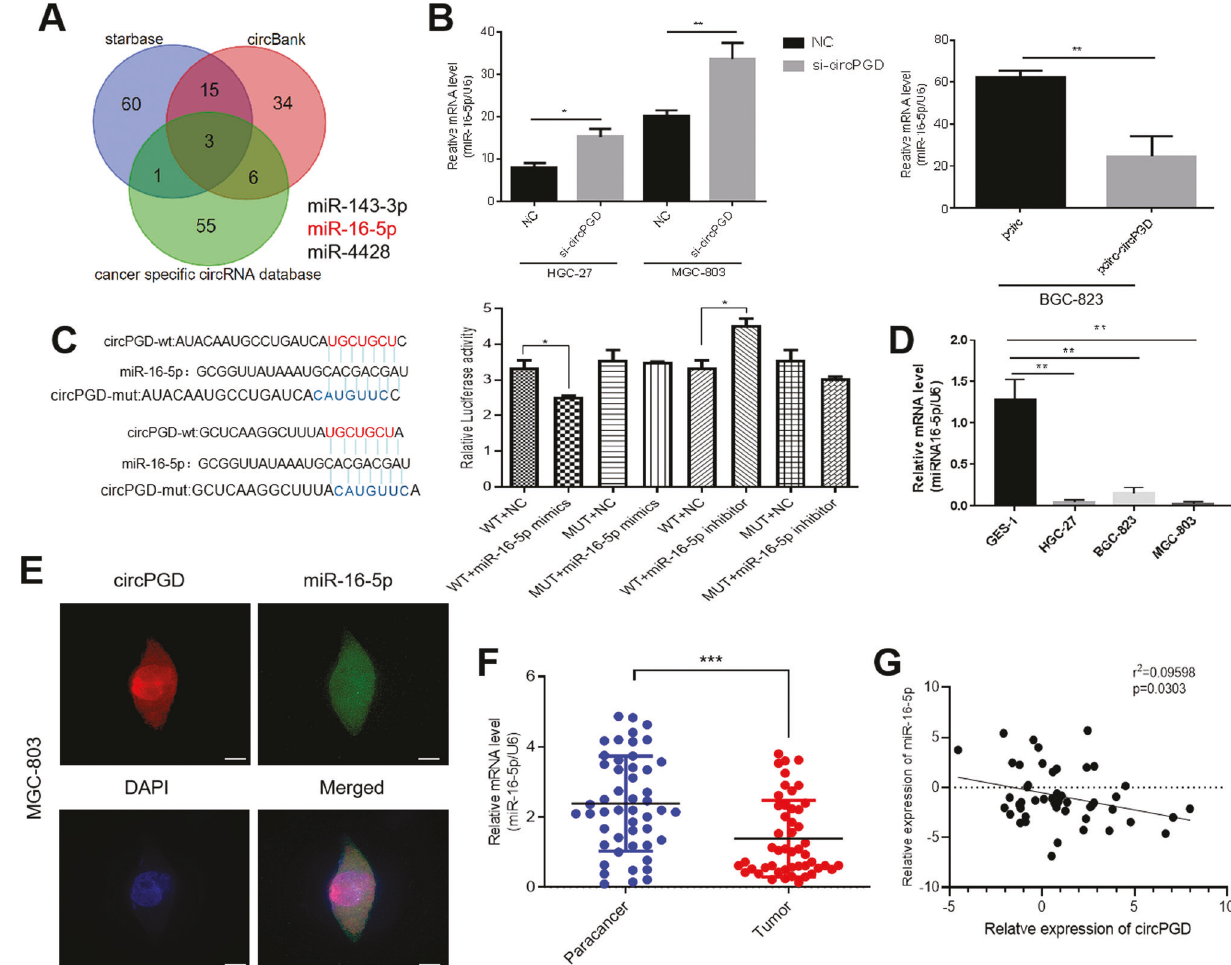
Fig. 3 CircPGD sponges miR-16-5p. A Three public databases estimated circPGD target miRNAs. B qRT-PCR monitored miR-16-5p level after abnormal circPGD level within GC cells. C The dual-luciferase reporter assay demonstrated the existence of binding sites in circPGD with miR- 16-5p. D qRT-PCR detected miR-16-5p level within GES-1 and GC cell lines. E Immuno fl uorescence detected circPGD together with miR-16-5p co-localization within MGC-803 cells, scale bars = 25 μ m. F The miR-16-5p expression decreased within tissues showing circPGD upregulation compared with circPGD downregulation. G Pearson correlation analysis found that circPGD was negatively related to miR-16-5p within 50 paired GC samples. * p < 0.05, ** p < 0.01, *** p <